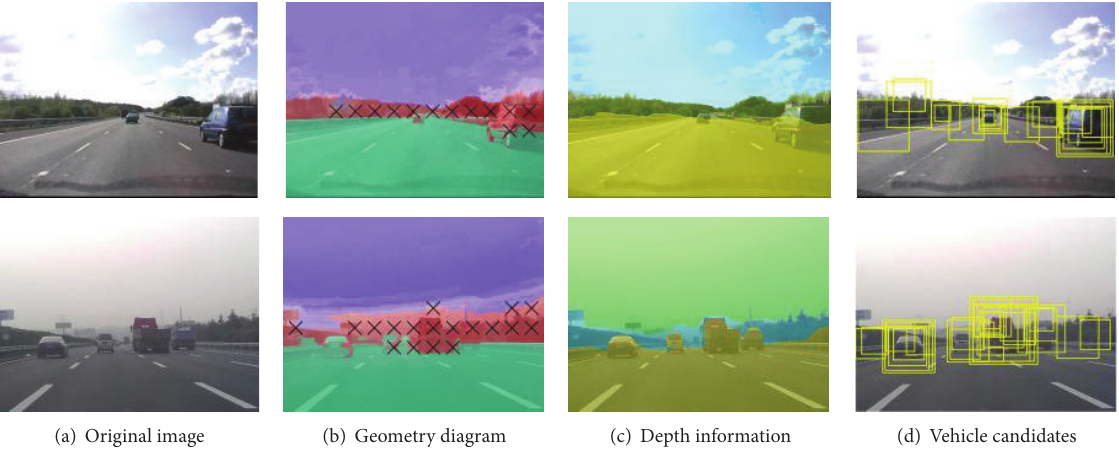
Figure 5: Two vehicle candidate generation results.